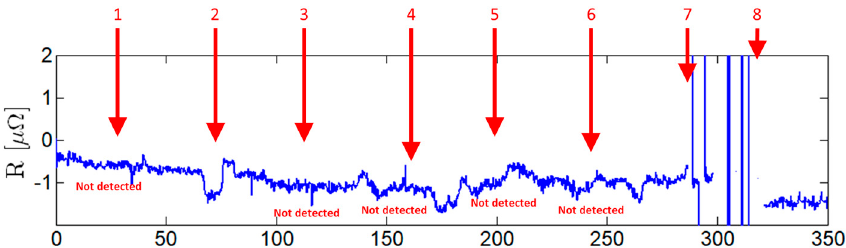
Figure 16. Straight line four-point probe output signal. Defects 1 to 8 as presented in Table 1.